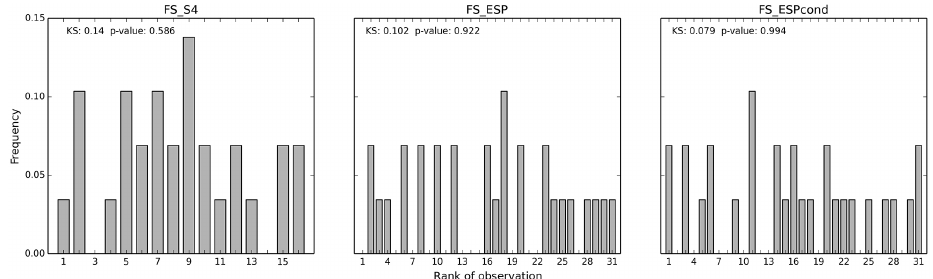
Figure 7. Rank histograms of SRI-6 for Station 1 for the three forecasting systems (FS_S4, FS_ESP, and FS_ESPcond). The results of the Kolmogorov–Smirnov test for uniformity are presented in each